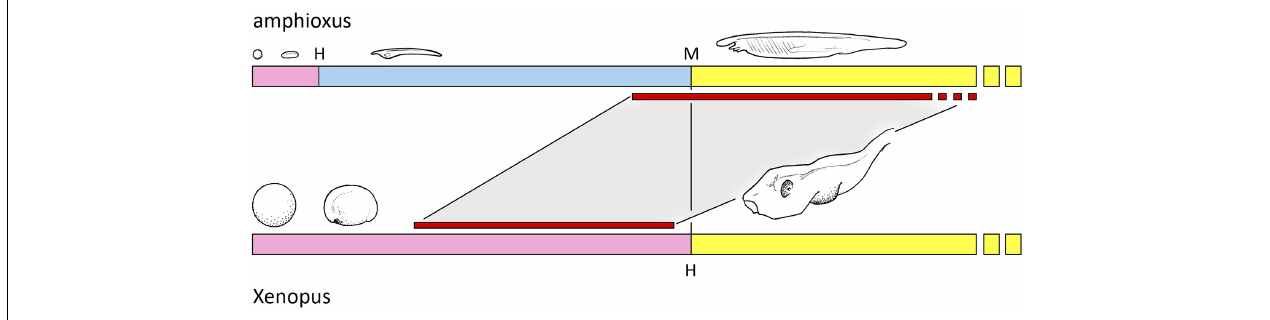
FIGURE 1 | The early life history of amphioxus compared with a representative aquatic vertebrate, Xenopus in this case. The embryonic stage (in pink) produces a hatching larva (at H), followed by a pelagic feeding phase (blue) that metamorphoses (M) to a juvenile that is essentially a small adult with adult habits (yellow). Embryogenesis in Xenopus also produces a larva, but is here shown in yellow because it corresponds less with the amphioxus larva than the juvenile in size and anatomical complexity, and the term larva is problematic anyway if, as here, the stages in question likely have independent evolutionary origins. Two trends are evident. First, that vertebrate eggs and embryos are orders of magnitude larger in volume, and so can be far more fully developed at hatching, and second, that this allows features that can only develop progressively in amphioxus to be incorporated into embryogenesis in vertebrates. The focus in this account is the telencephalon and its putative amphioxus homolog, whose periods of development, inferred for amphioxus from data reported by Benito-Gutierrez et al. (2021), are shown by the red